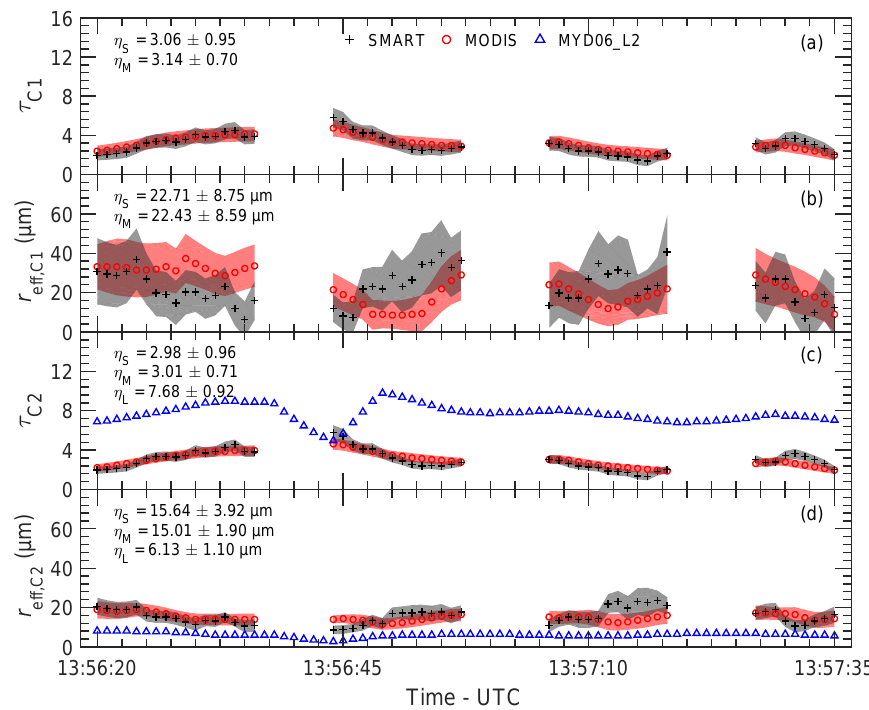
Figure 13. Time series of cirrus τ (a) and r eff (b) retrieved from SMART (black) and MODIS (red) using combination 1 (C1). The dark shaded area describes retrieval uncertainties. η S (SMART) and η M (MODIS) represent the mean standard deviation along time series. Panels (c) and (d) are the respective properties retrieved using combination 2 (C2). Cloud properties derived from the MODIS cloud product (MYD06_L2), τ L and r eff , L , 2130 , are shown in blue (only in panels c and d ) with the corresponding η L